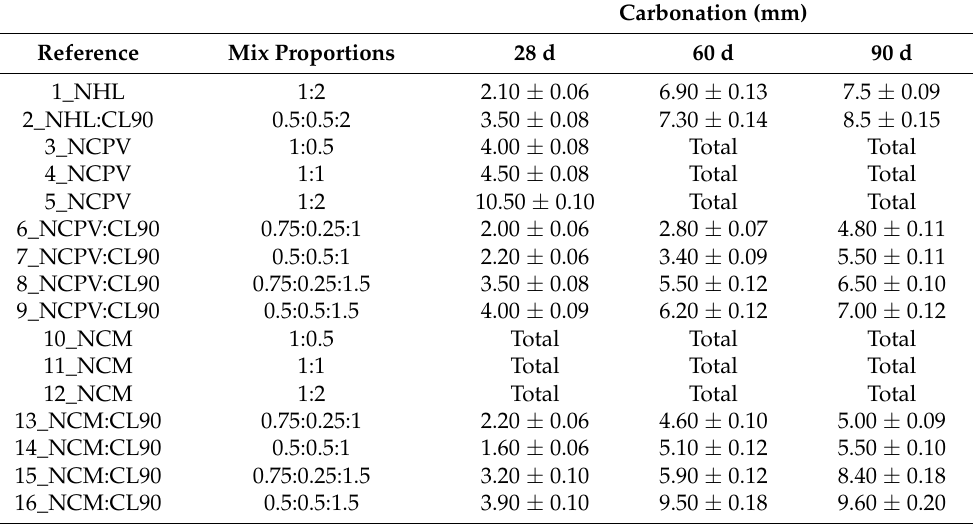
Table 6. Carbonation of mortars after 28, 60, and 90